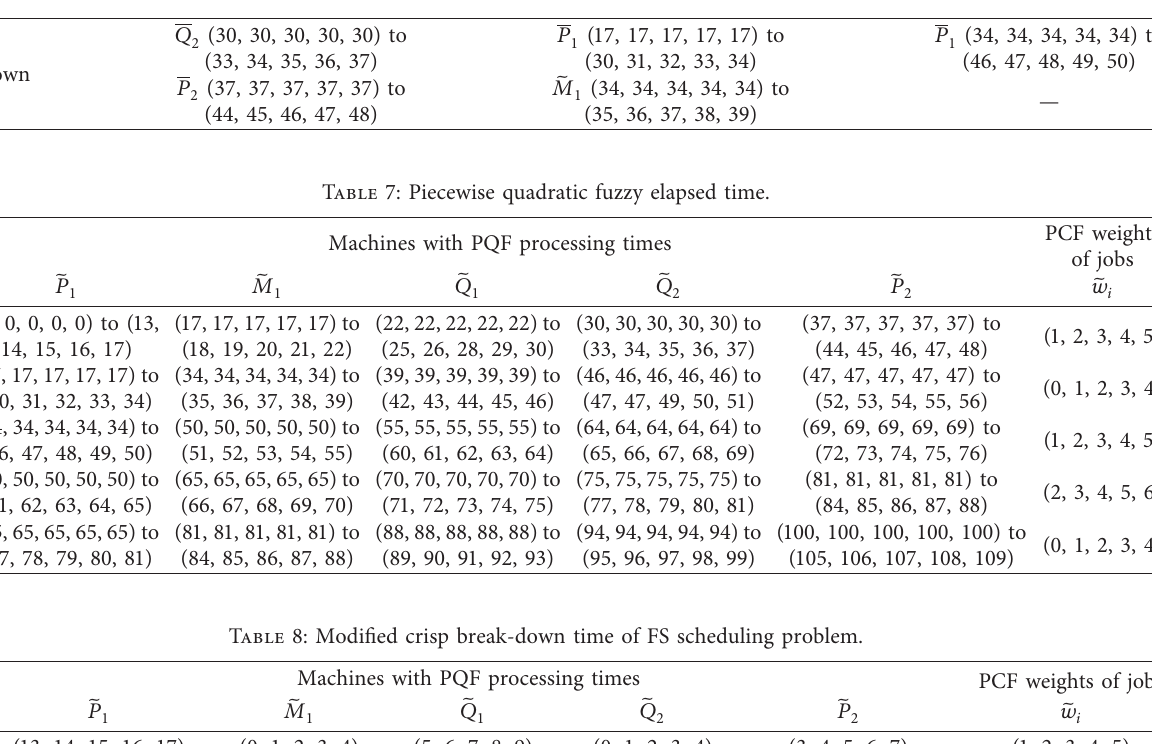
Table 6: Break-down effect on jobs.